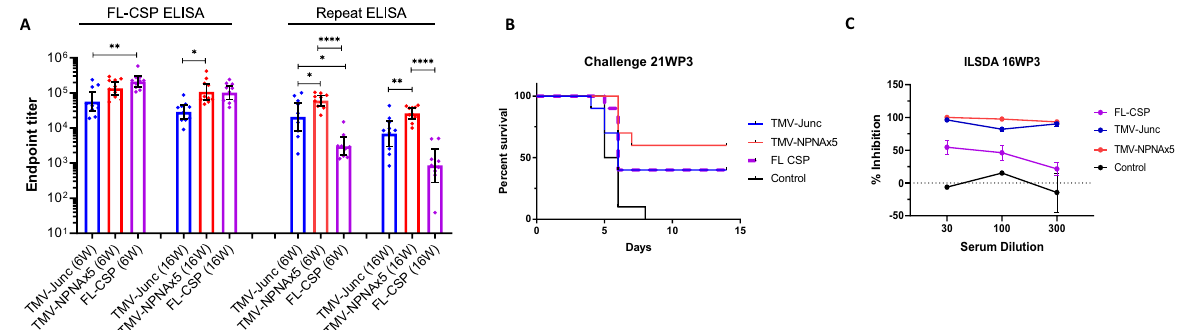
Fig. 4 Study 1 immunogenicity and functional assessment at 21WP3 for TMV-Junc, TMV-NPNAx5, FL-CSP. A Geometric mean titer of serum at 6 and 16 weeks post 3rd (6 W, 16 W) for mice challenged at 21WP3 against FL-CSP (FL) and the repeat peptide. Bars are geometric mean ± 95% CI. Group means were compared by one-way ANOVA followed by Tukey ’ s correction; **** ( p < 0.0001), ** ( p < 0.01), or * ( p < 0.05). B Survival curves of mice challenged at 21WP3. C Mean ILSDA performed at 1:30, 1:100, and 1:300 pooled serum dilution at 16WP3.